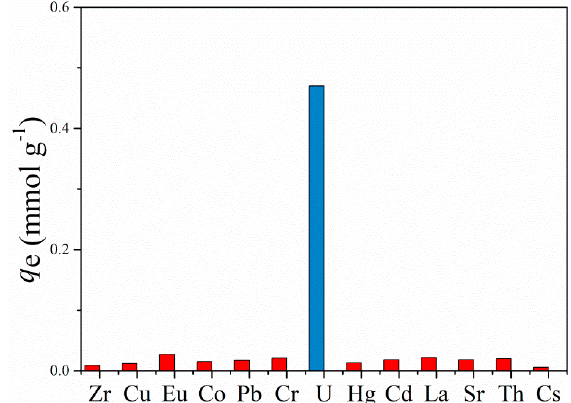
Figure 7. Competitive adsorption of coexistent ions by PVKAP, C 0 = 0.5 mmol L − 1 for all cations, pH = 5.0 ± 0.1, m/V = 0.05 g L − 1 .